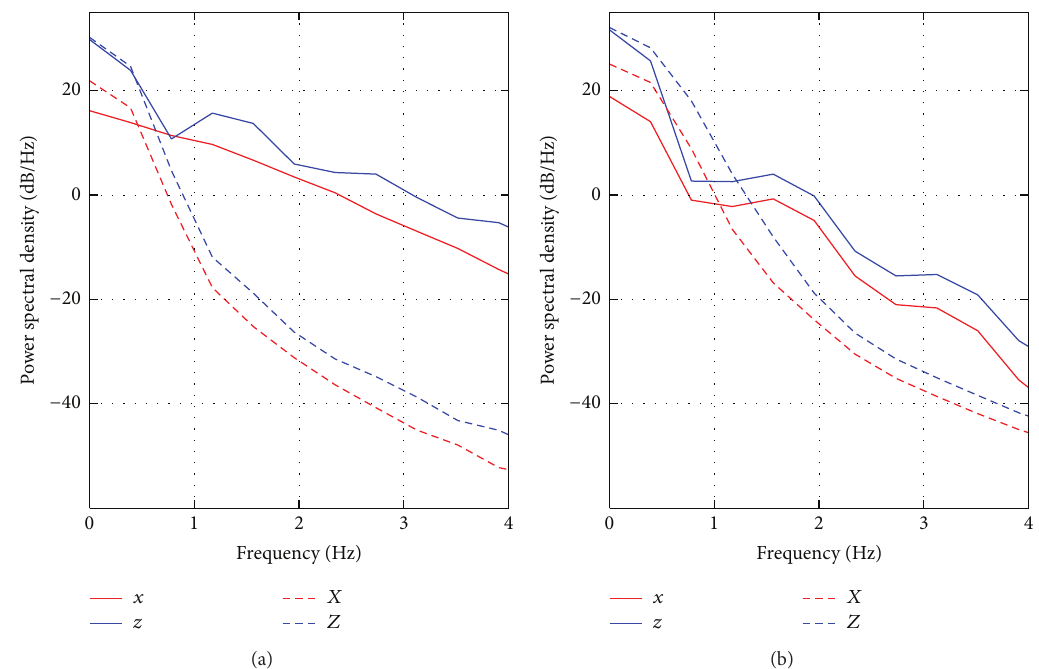
Figure 10: Power spectral density estimate obtained by Welch method for fast ( 𝑥 and 𝑧 ) and slow ( 𝑋 and 𝑍 ) dynamic variables for 𝑐 = 0.15 (a) and 𝑐 = 0.8